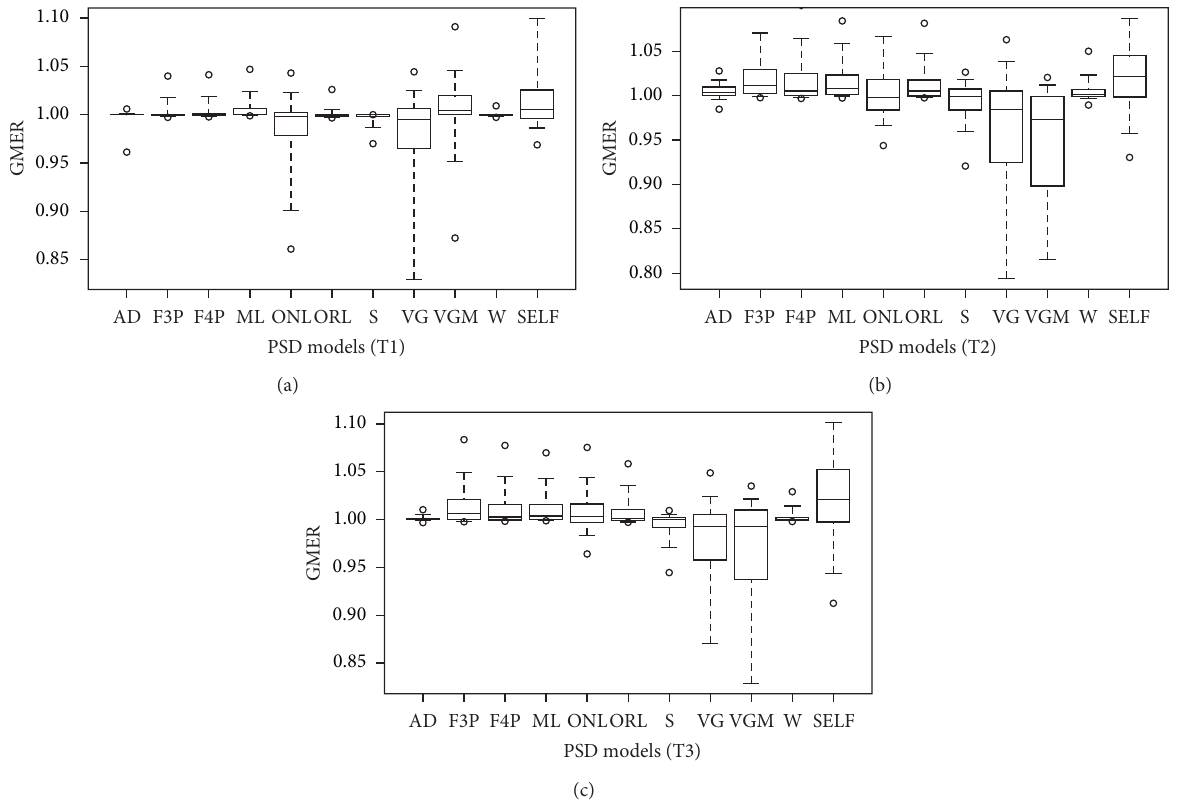
Figure 4: Box plot for geometric mean error ratio (GMER) percentiles as a criterion for assessing the performance of 11 models, (a) T1 scheme soils, (b) T2 scheme soils, and (c) T3 scheme soils.